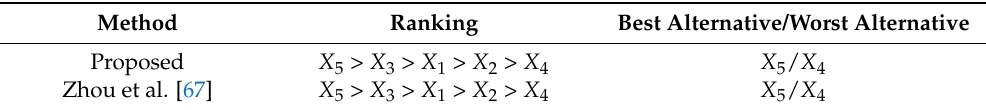
Table 18. Comparison of ranking of